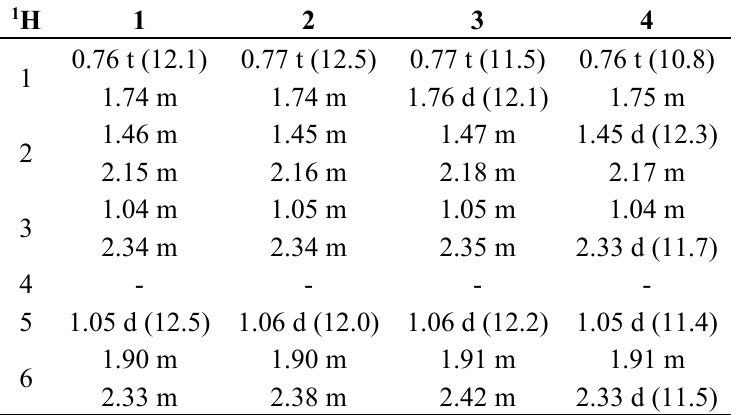
Table 1. 1 H-NMR chemical shift values (δ, ppm) for the compounds 1 – 4 in pyridine- d 5 a−c